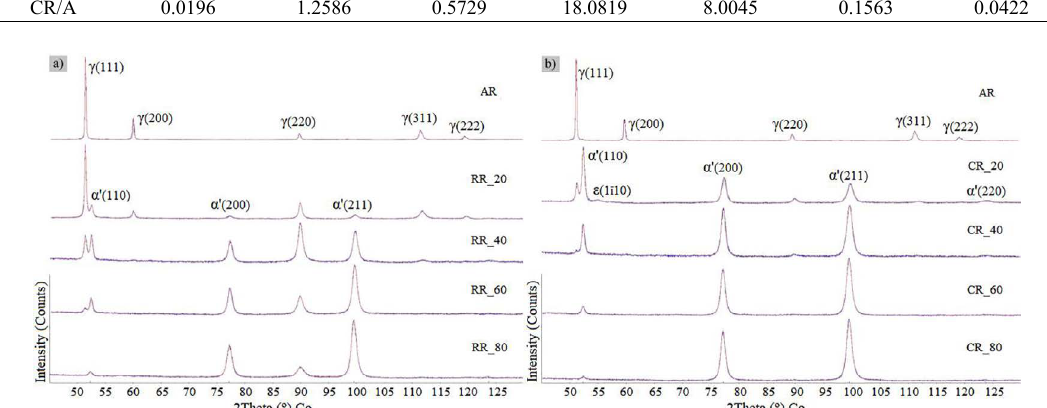
Figure 1. Diffractograms of rolled samples at 298 K (a) and 155 K (b) with reductions of 20, 40, 60 and